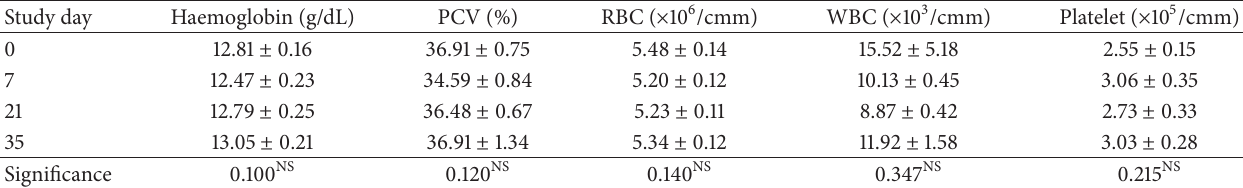
Table 4: Haematological profiles of flea infested dogs before and after Fiprofort Plus